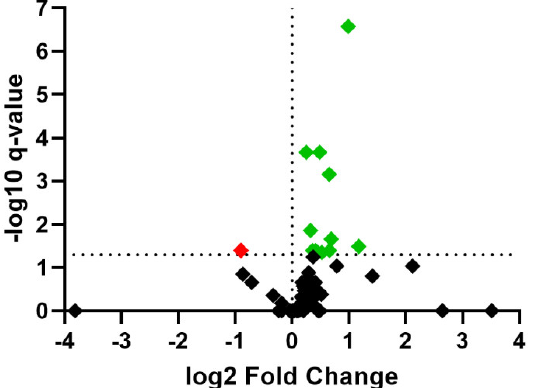
Figure 1. Venn diagram of the proteins identified. Number of proteins identified in each treatment (exclusive), the intercept containing the number of proteins common in both treatments. RM = re- striction maintenance; MR = maintenance restriction.